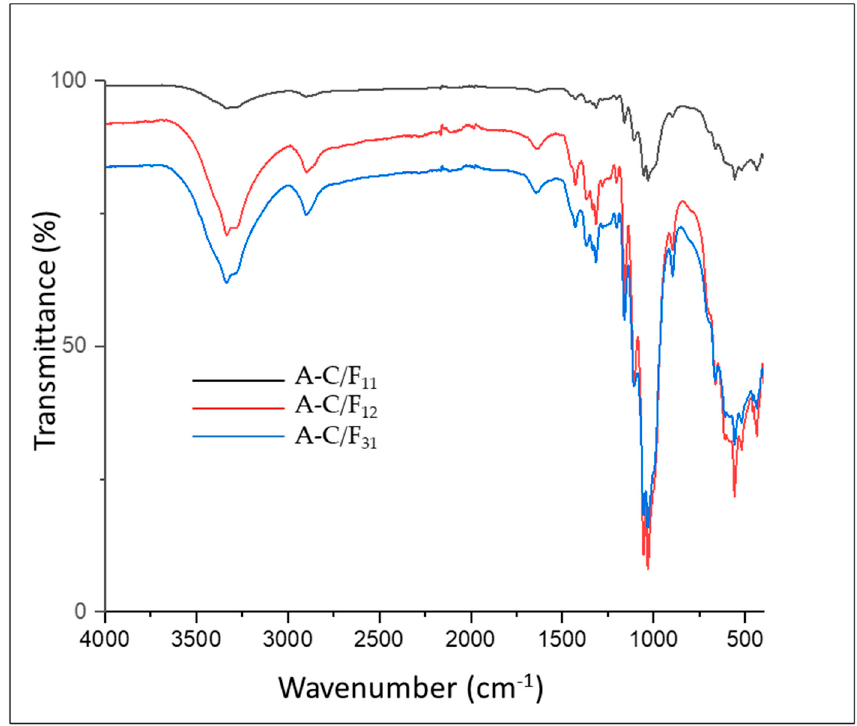
Figure 3. FTIR spectra of aerogel-based CNC/CNF mixture A-C/F 11 , A-C/F 12 , and A-C/F 31.